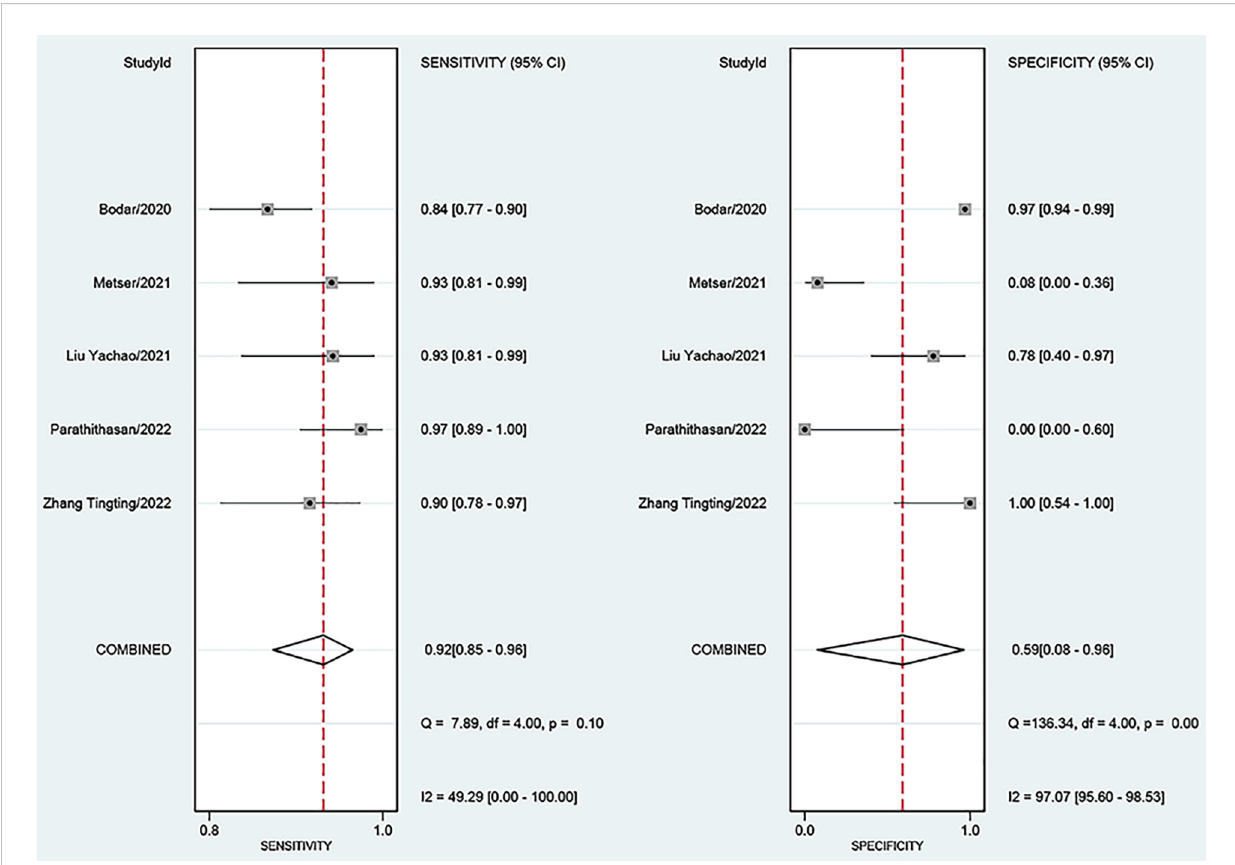
FIGURE 3 Forest plot showing the sensitivity and speci fi city of 18 F-DCFPyL PSMA PET for primary prostate cancer. PSMA, prostate-speci fi c membrane antigen.